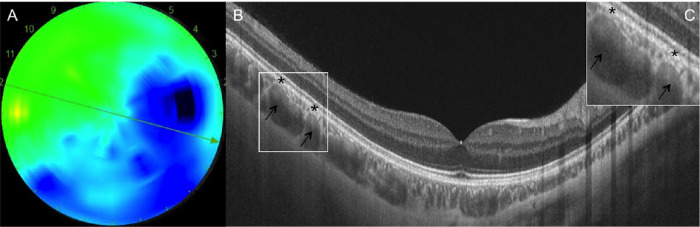
Example of large choroidal vessels in a medium-thin choroid. (A) The 12-mm CT map shows an asymmetrical CT pattern. Color code: red, >400 µm; yellow, 300–400 µm; green, 200–300 µm; blue, <200 µm. (B) The OCT B-scan corresponding to the green arrow in (A) shows the presence of large choroidal vessels, presumably veins (black arrows), occupying almost the entire CT, with no obvious choriocapillaris thinning (black asterisks). (C) Insert showing the magnification of the area of interest, the white square in (B); the choriocapillaris is still visible between the large vessel walls and the retinal pigment epithelium (black asterisks).